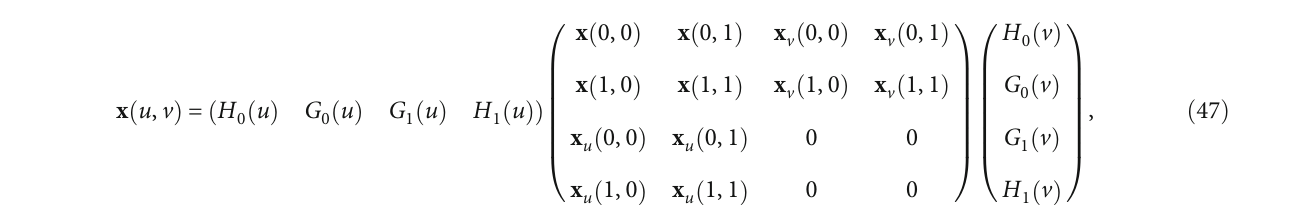
Figure 10: Mean curvature of the bilinear interpolation surface ruled